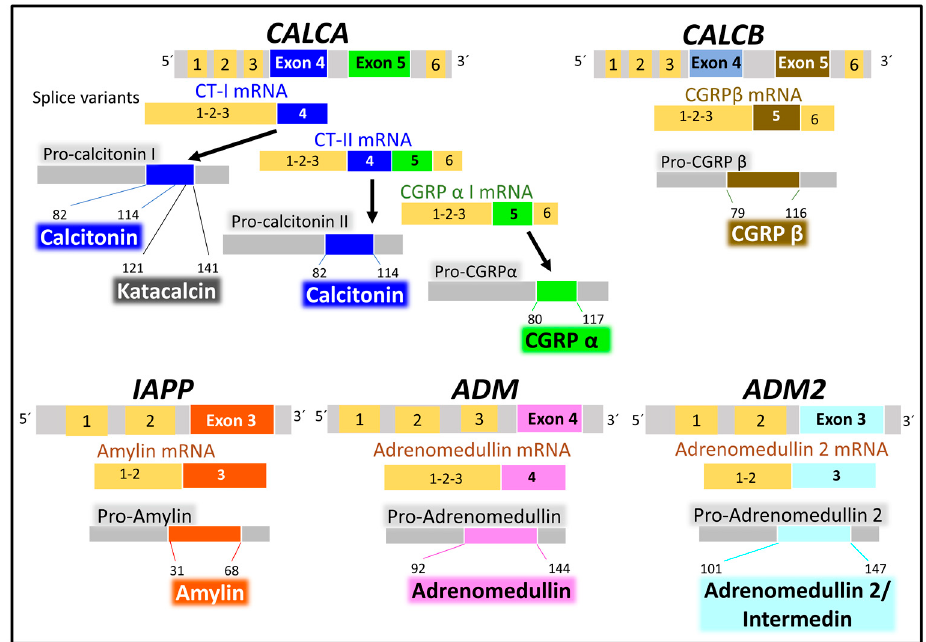
Figure 8. The figure represents the human calcitonin/CGRP family genes and their main peptide products, calcitonin, CGRP (calcitonin gene-related peptide) isoforms α and β , amylin, adrenomedullin, and adrenomedullin 2/intermedin. Alternative splicing generates mRNA isoforms transcribed into peptides that undergo post-translational modifications (protein hydrolysis, disulfide bridge formation, and amination of C-terminal amino acid), giving rise to functional peptides. Data supporting this scheme are from the UNIPROT [25] and Entrez Gene (National Library of Medicine) [34] databases. Numbers indicate the residue position within the peptide sequences.